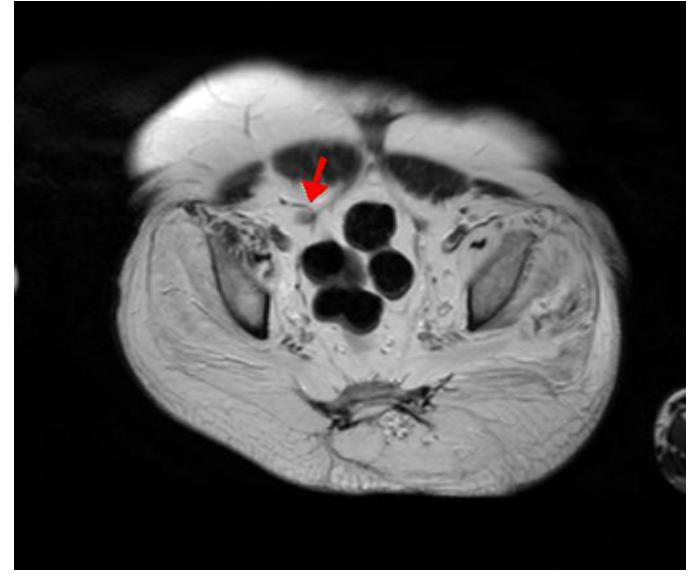
FIGURE 5. Axial T-2 weighted image demonstrating the course of the right vas deferens crossing and kinking the lower ureter at the site of incomplete obstruction (arrow).